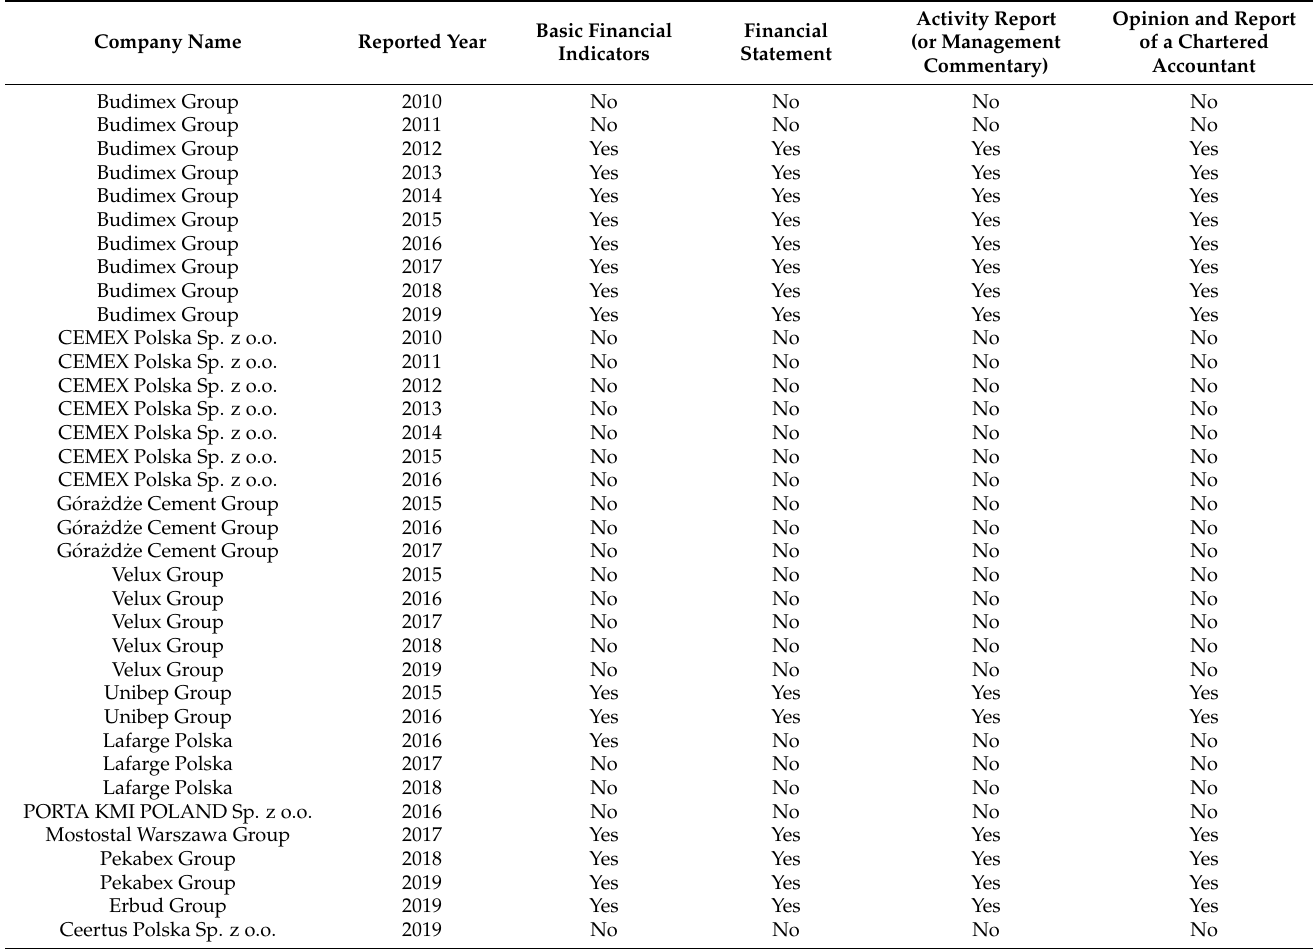
Table A3. Financial data published on the companies’